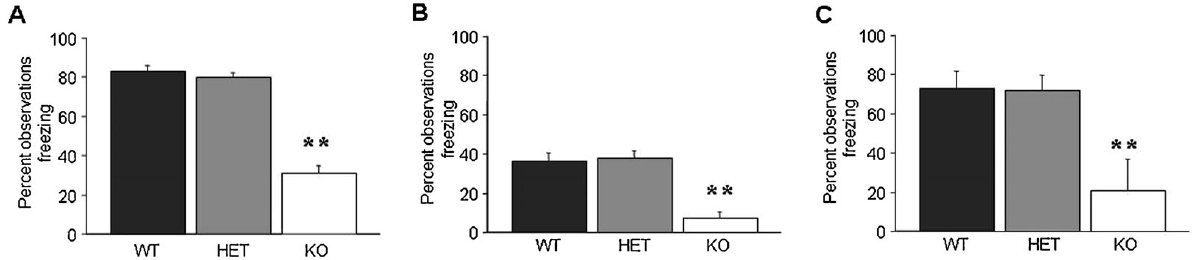
Figure 1. GluR1 KO but not HET exhibit impaired multi-trial delay and trace fear conditioning. ( A ) KO showed less freezing than WT during tone recall in the multi-trial delay fear conditioning paradigm. ( B ) KO showed less freezing than WT during context recall in the multi-trial trace fear conditioning paradigm (n ¼ 15/ genotype). ( C ) KO showed less freezing than WT during tone recall in the multi-trial trace fear conditioning paradigm (n ¼ 6–12/genotype). Data are means (cid:3) SEM. **p < 0.01 versus